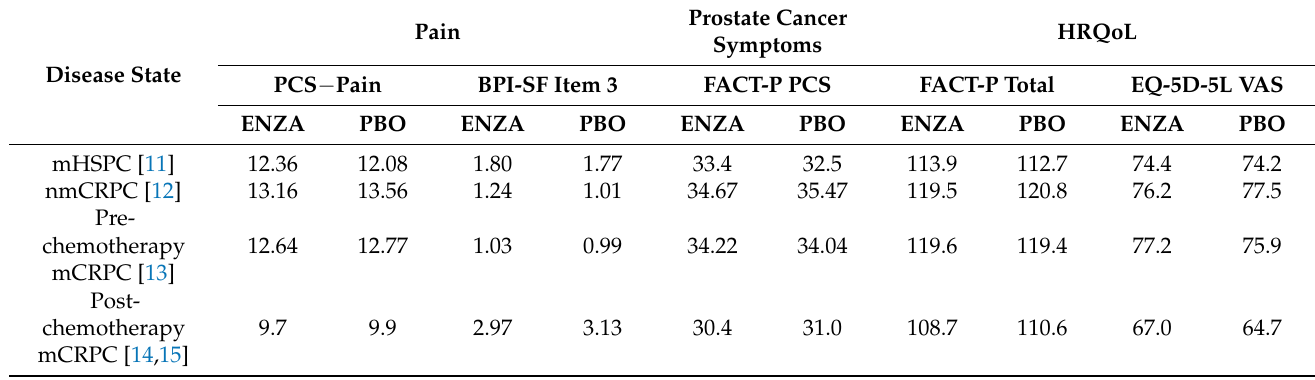
Table 4. Mean HRQoL scores at BL.